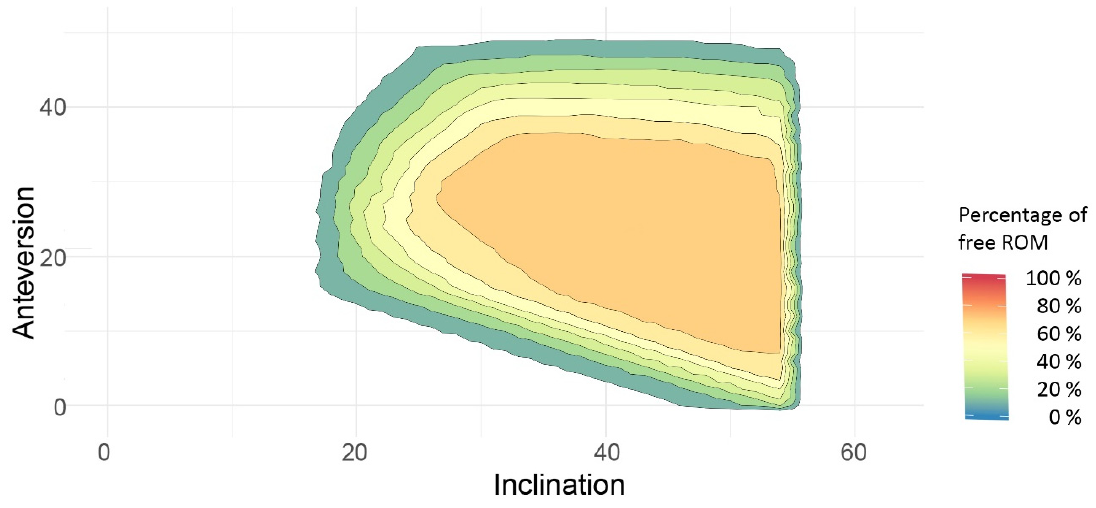
Figure 3. Superposed combined safe zones of the study cohort. ROM, range of